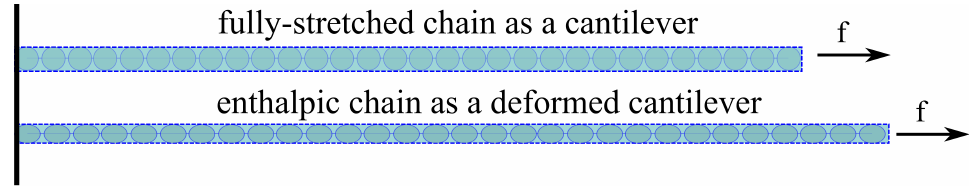
Figure 5. Deformation of a polysaccharide chain after fully-stretched